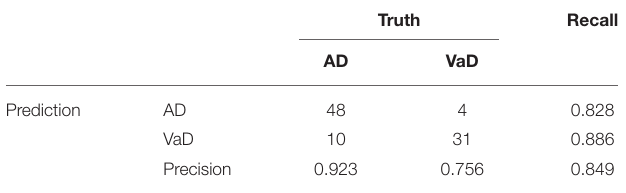
TABLE 5 | The confusion matrix of SVM model in a single experiment.